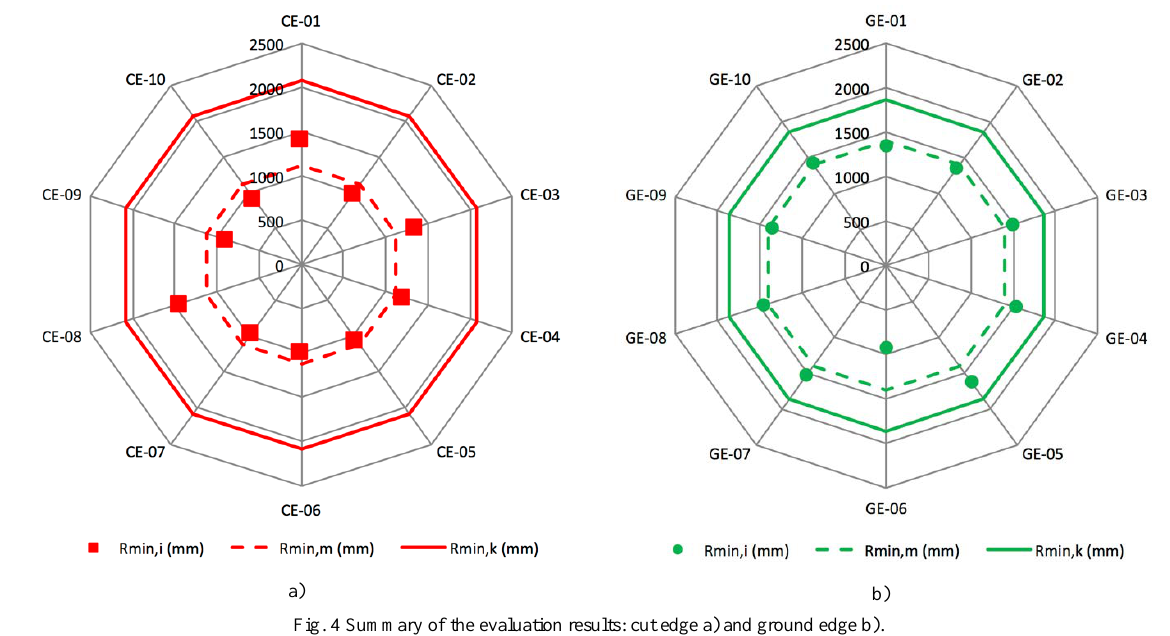
Fig. 4 Summary of the evaluation results: cut edge a) and ground edge